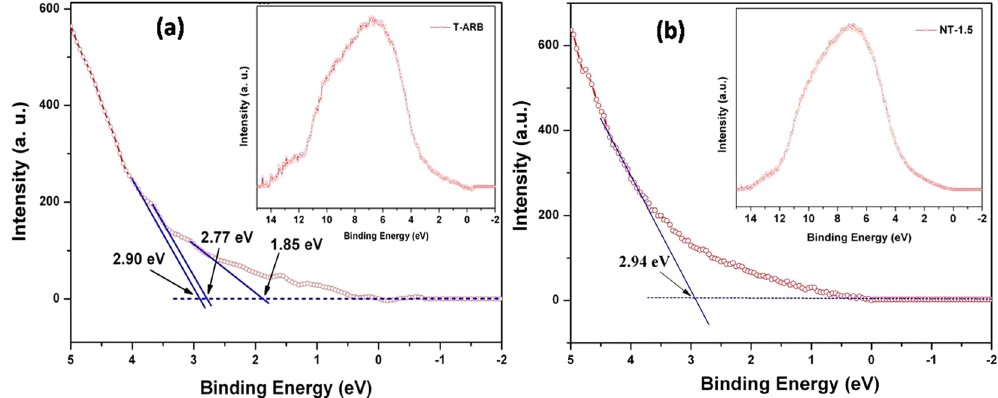
Figure 13. Synchrotron UPS spectra of ( a ) T-ARB; and ( b )